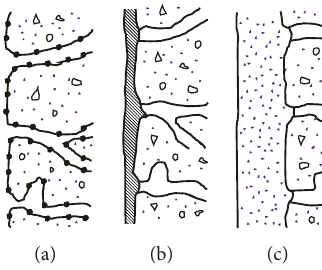
Figure 1: Types of surface treatments: (a) impregnation; (b) coating; and (c) cementitious coating surface.